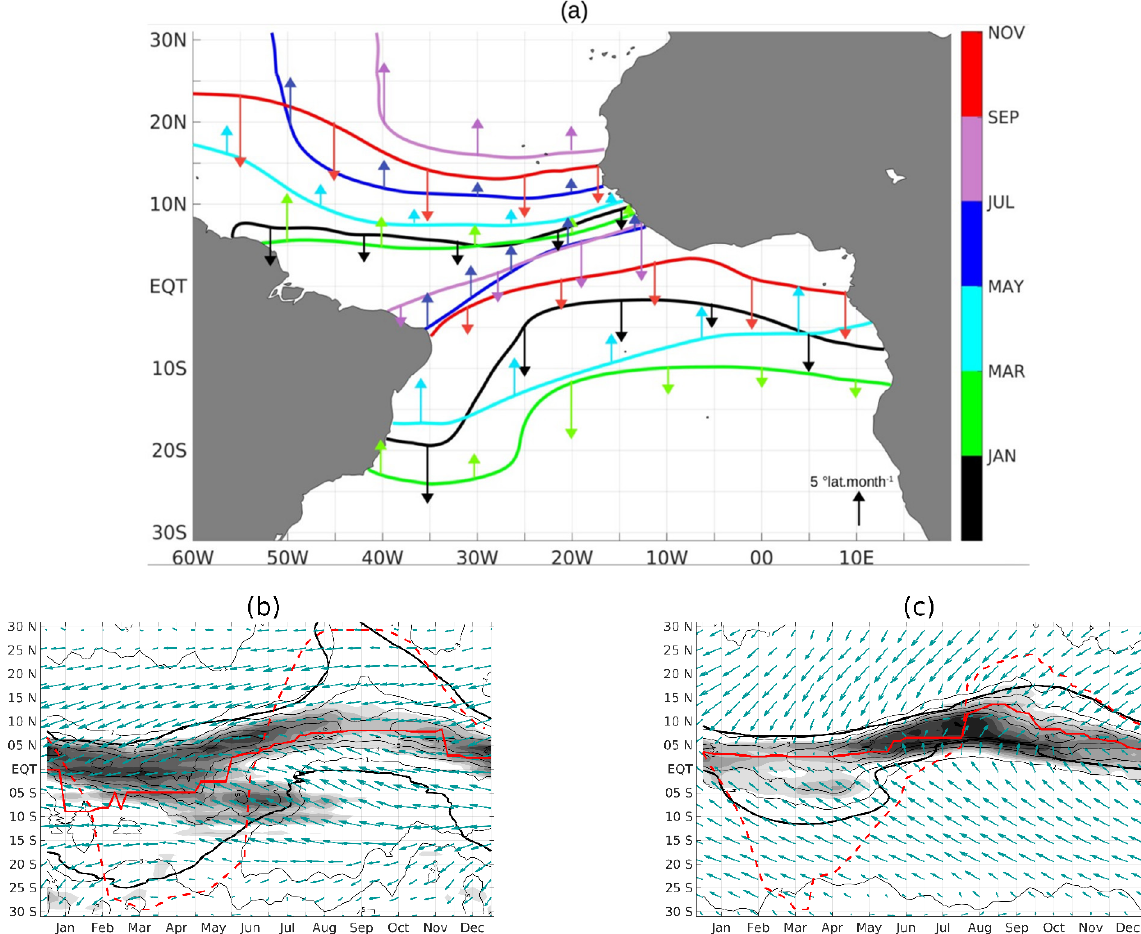
Figure 1. Spatio-temporal climatological variations of the Atlantic Warm Pool derived from observations. ( a ) Northern and southern 27 °C boundary isotherms (color lines) and migration meridional velocity (° lat.month − 1 , vectors), monthly averaged, spatially low-pass filtered, plotted every other month. ( b , c ) Time-latitude diagrams of surface wind convergence (s − 1 , color), rain (mm.day − 1 , black contour), 10 m wind (m.s − 1 , vectors), 27 °C isotherms (bold black line), maximum SST (red line), and maximum SST for the bucket model (red dashed line). Zonal average over the 60° W–30° W ( b ) and the 30° W–15° E ( c ) sectors.